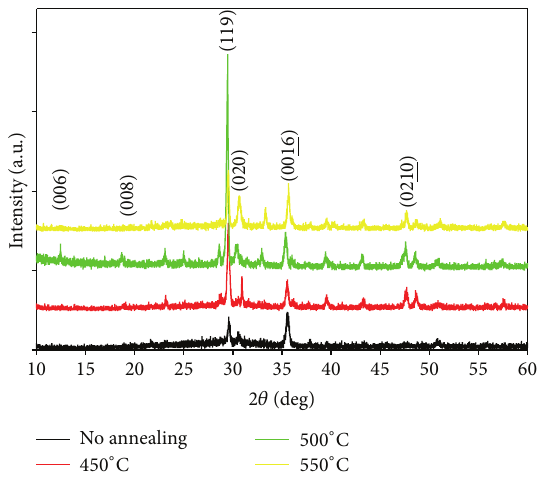
Figure 3: XRD patterns of the CBTi144 thin films with different annealing temperatures.